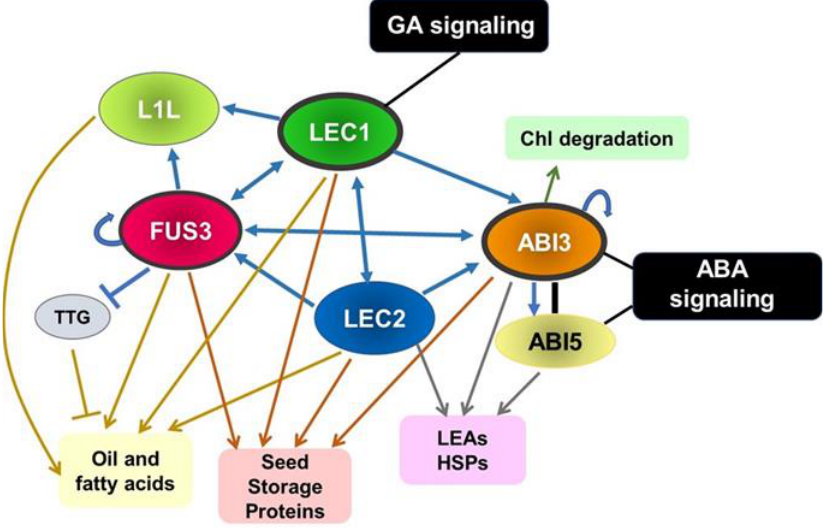
Figure 2. LAFL network regulates seed development. Arrows and blunted lines indicate activation and repression, respectively. Black line between ABI3 and ABI5 indicate the interaction of these proteins. LEC1, LEC2, and FUS3 (surrounded by the thick black line) are involved in acquisition of DT and all LAFL proteins are involved in the regulation of dormancy. LEC1 is related to GA signaling and ABI3 and ABI5 are related to ABA